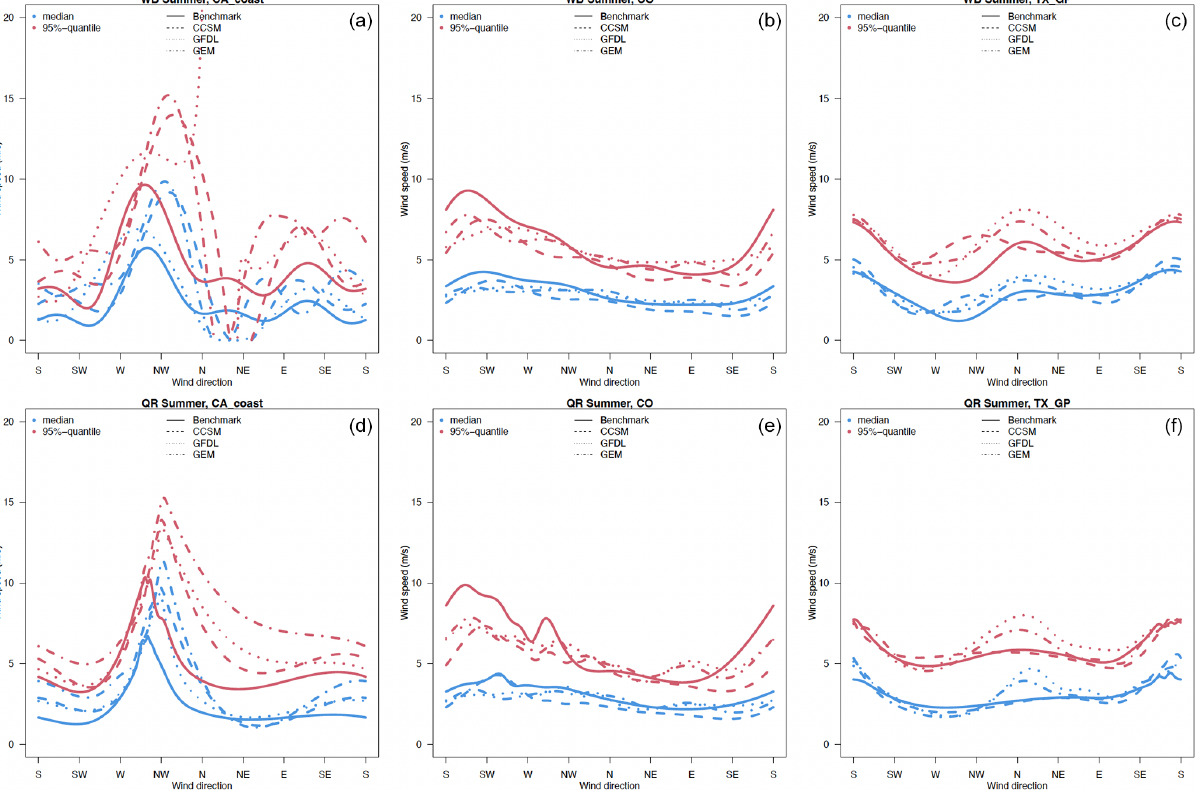
locations can be found in Sect. S2. Compared with the wind speed quantile estimates conditioned on the direction from the historical period, the projected winds at the Colorado Mountains location show evident weaker wind speeds condi- tioned on direction, especially for the dominant wind direc- tion southwesterlies, but also other directions such as wester- lies and northwesterlies from both the quantile regression and Weibull distributional regression models at all three quan- tiles. Figure 9 shows similar statistics for the northern Great Plains location in North Dakota, and the prevalent wind di- rections tend to be similar from the historical to the late cen- tury periods. The overall wind speed tends to show a decrease in intensity (across all quantiles) in particular in the dominant direction